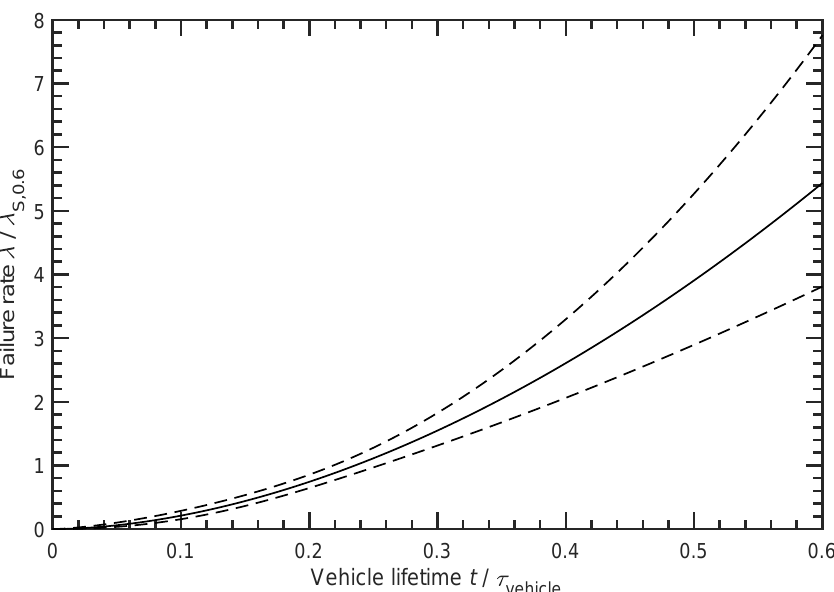
Figure 5. The normalised failure rate λ PG ( t ) of the failure mode Plates and Grids with a shape parameter b = 2.812 and a normalised scale parameter T = 0.582 is shown. In addition, the upper and lower confidence limits for a confidence level of 95% are displayed.